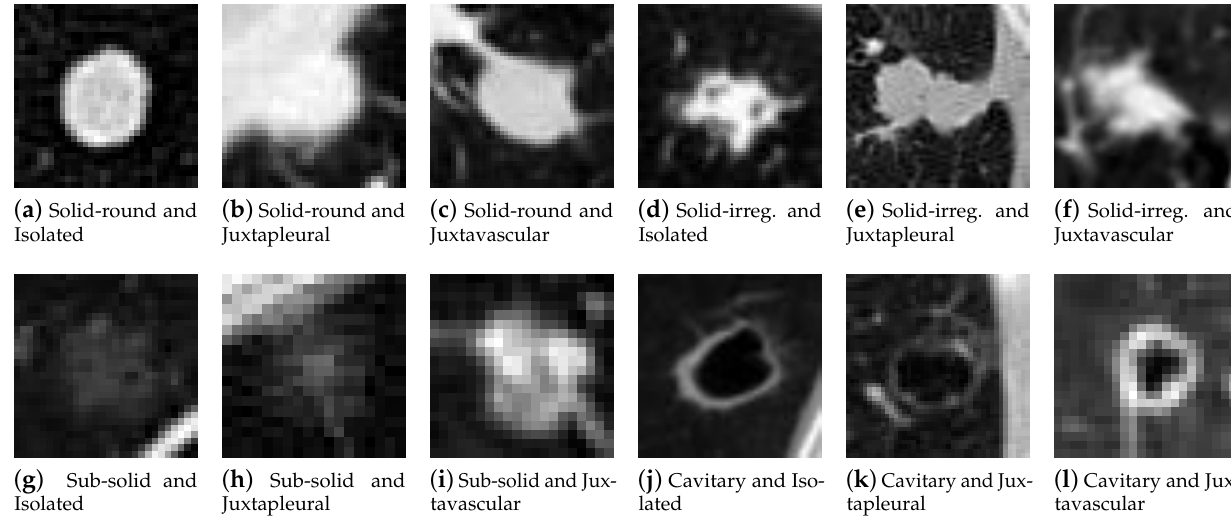
Figure 9. Examples of Lung Image Database Consortium (LIDC) nodules from every category and